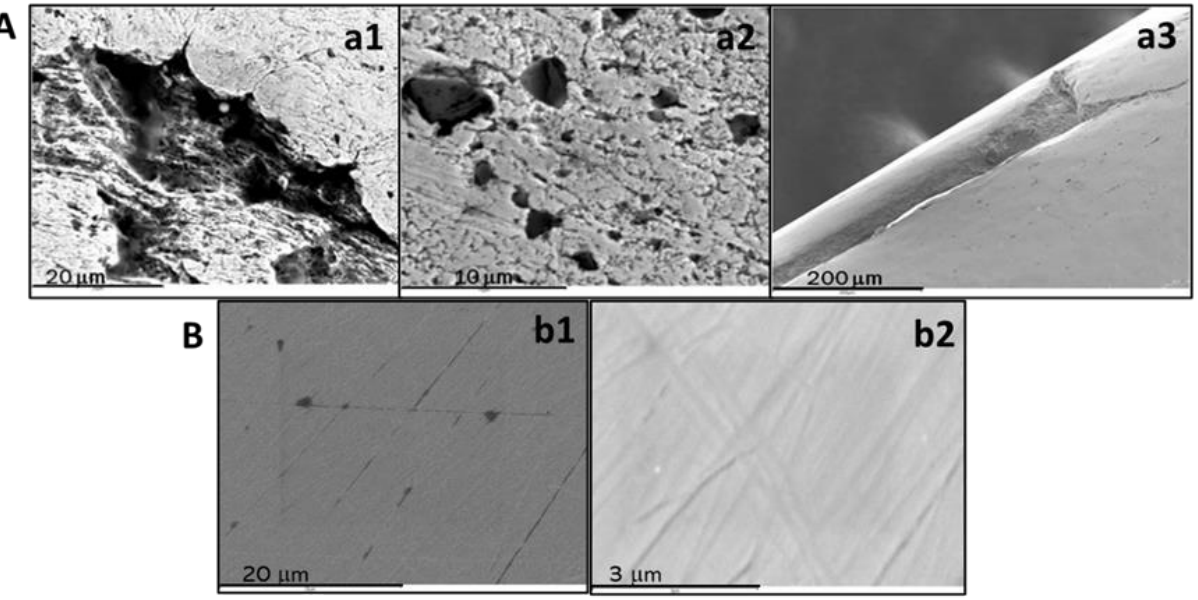
Figure 1. SEM images of a commercial 18K gold quaternary alloy (Au-Ag-Cu-Zn) wire ( A ) and plate ( B ). Hollows caused by shrinkage ( a1 ), cooling ( a2 ), and fracture by stretching ( a3 ). Surface micrographs at low ( b1 ) and high magnification ( b2 ).